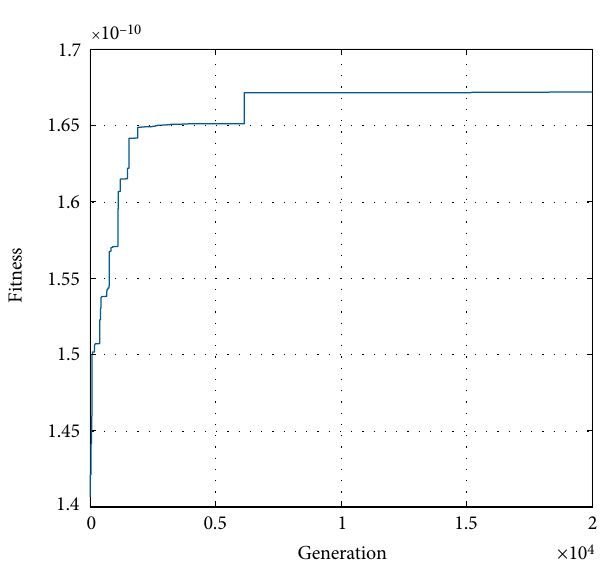
Figure 7: Convergence of the genetic algorithm using data from 2017 as an example.